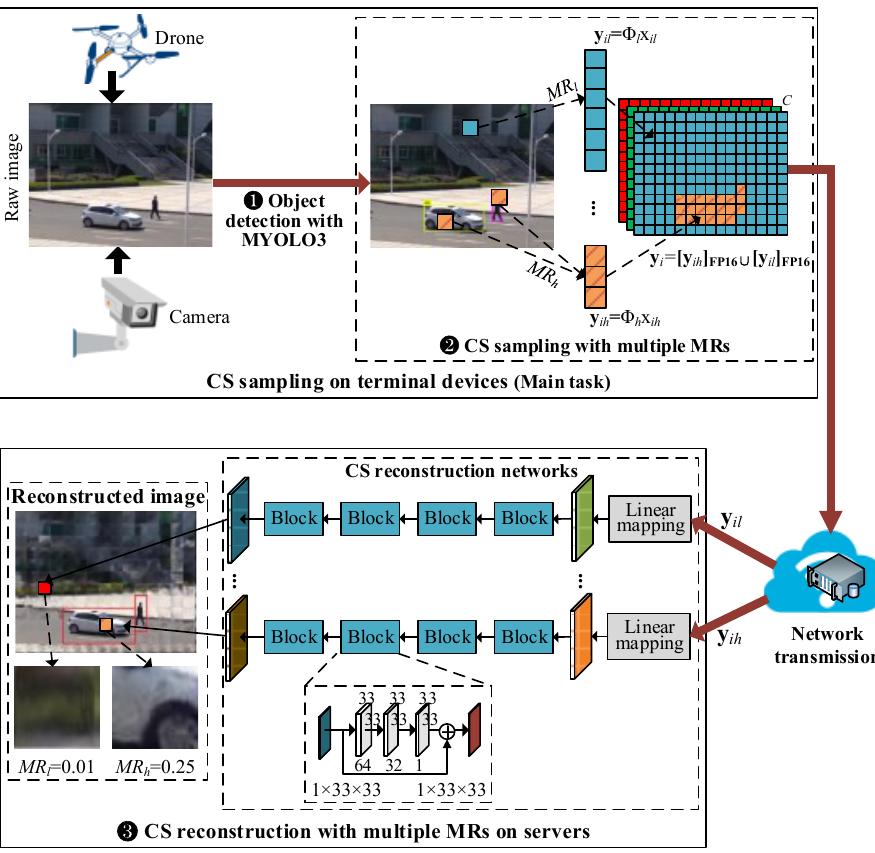
Figure 1. Illustration of the proposed MRCS. The main task of MRCS is CS sampling of natural images with multiple Measurement Rates (MRs), e.g., 0.25 and 0.01. [*]FP16 denotes CS measurements are represented with half-precision